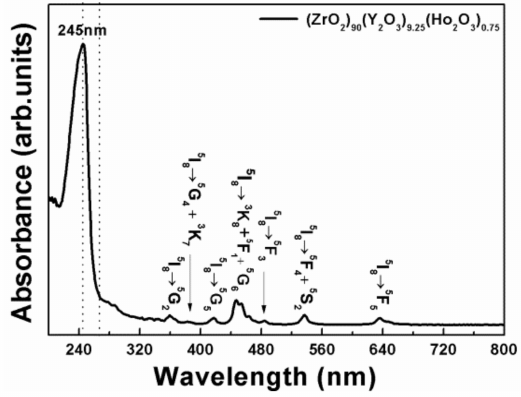
Figure 8. UV-vis absorption spectrum of the (ZrO 2 ) 90 (Y 2 O 3 ) 9.25 (Ho 2 O 3 ) 0.75